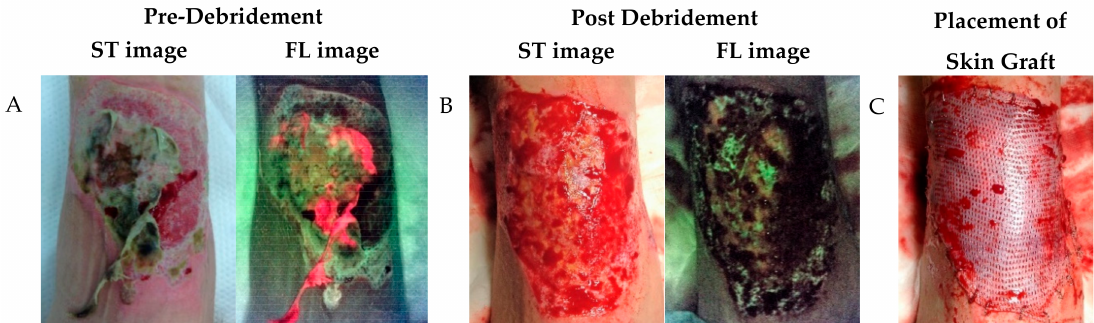
Figure 4. Case Study 2—Debridement of a Burn Wound. ( A ) Pre-debridement, red bacterial fluorescence is observed through the burn and within the slough. ( B ) Post-debridement the de-vitalized tissue and bacterial burden is largely removed. Red bacterial fluorescence is no longer observed. ( C ) Post-debridement and after confirmation of reduced bacterial load, a skin graft was applied to the